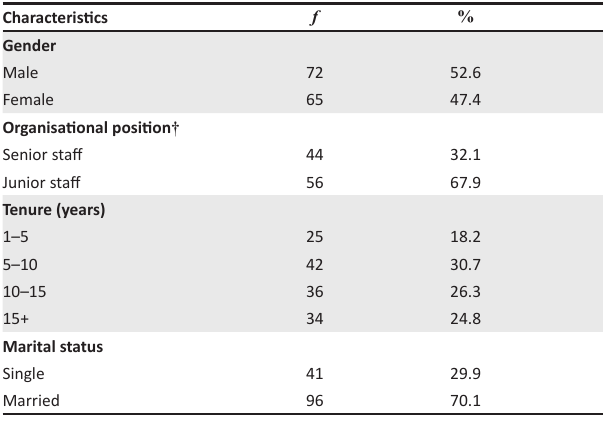
TABLE 1: Percentage of responses by category of gender, organisational status and marital status ( n = 137).